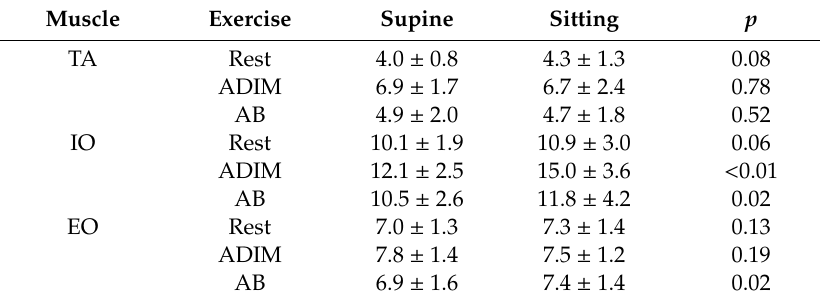
Table 4. Muscle thickness (between positions).